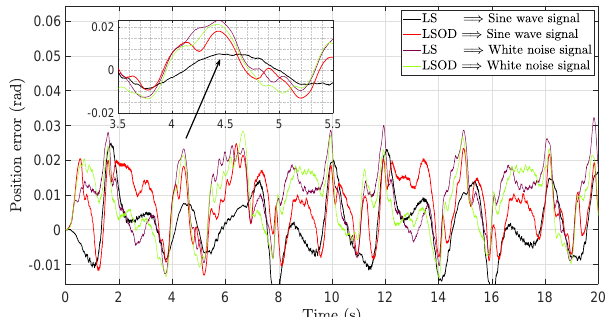
Figure 9. Position errors produced by control law (61) with parameter estimates β ∗